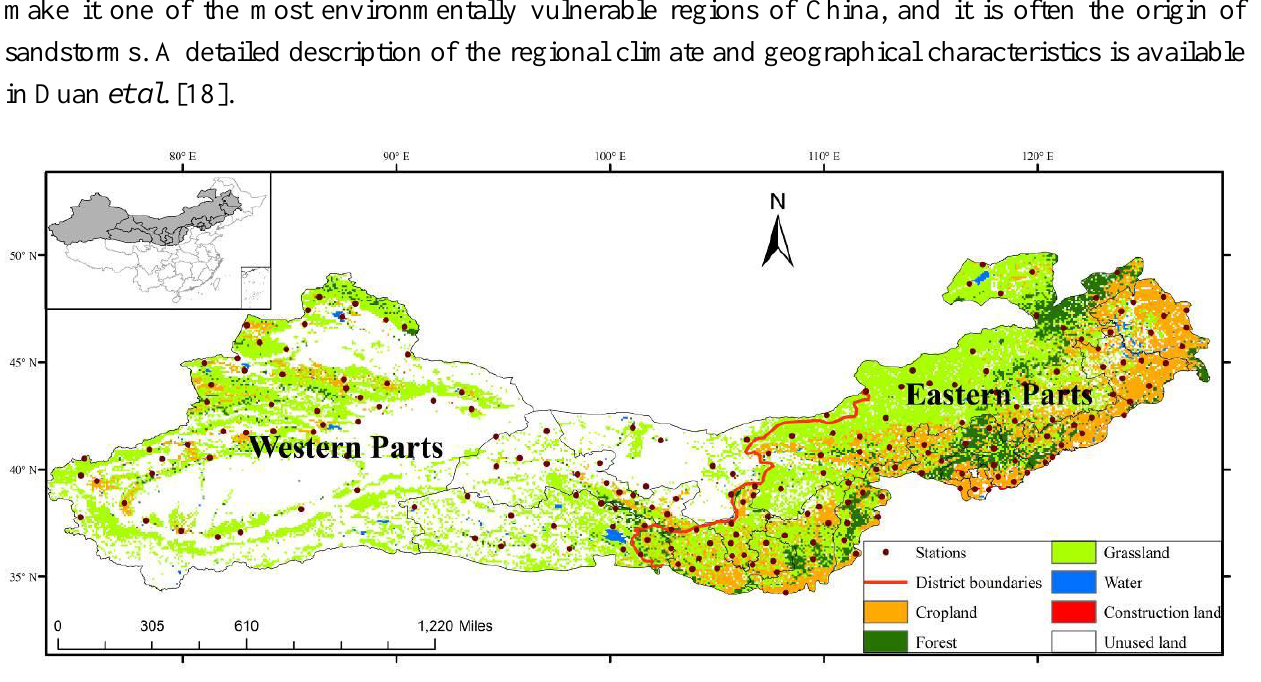
Figure 1. Map of the research area showing the distribution of land-use types and climate stations. A land-use map from the late 1980s was